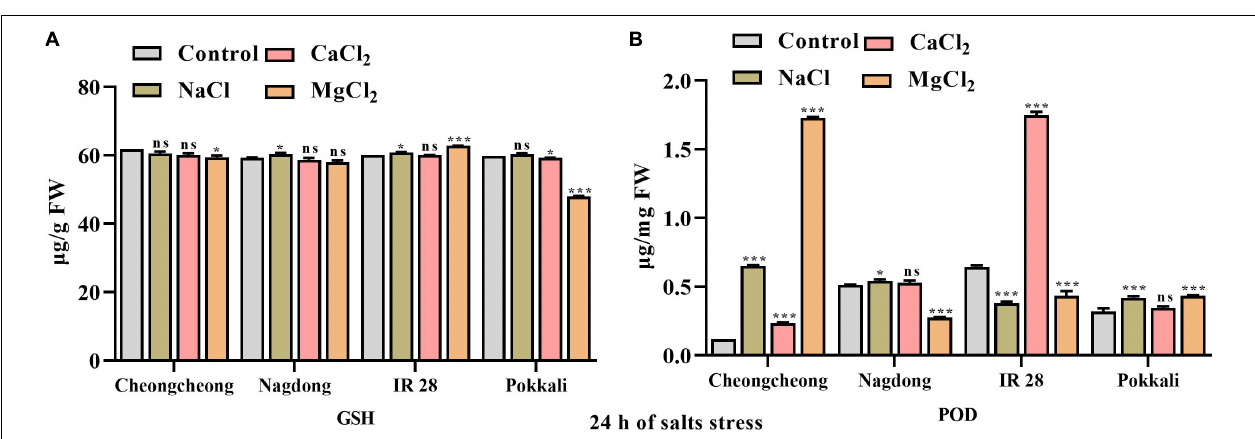
FIGURE 5 | Effect of 150 mM of different salts on GSH and POD contents in the leaves of different rice genotypes. The GSH (A) and POD (B) activity was determined after 24 h of salt stress. Statistical analysis was calculated by the Bonferroni posttest one-way repeated-measures analysis of variance. Asterisks in the vertical bar indicate a significant difference at * p < 0.05, *** p < 0.00, compared to